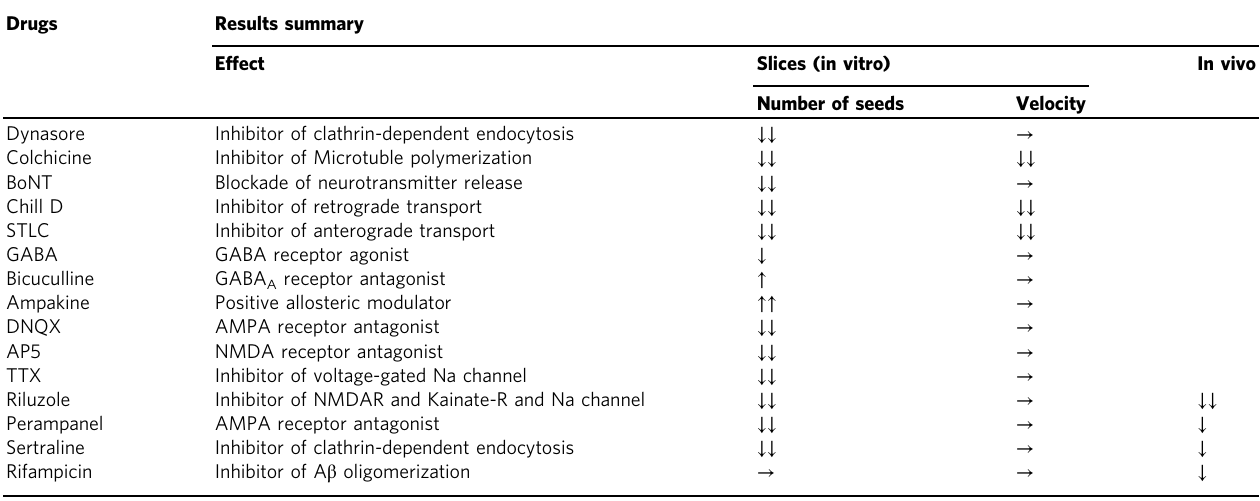
Table 1 Results summary for pharmacological effects on dynamics of α -syn seeds.